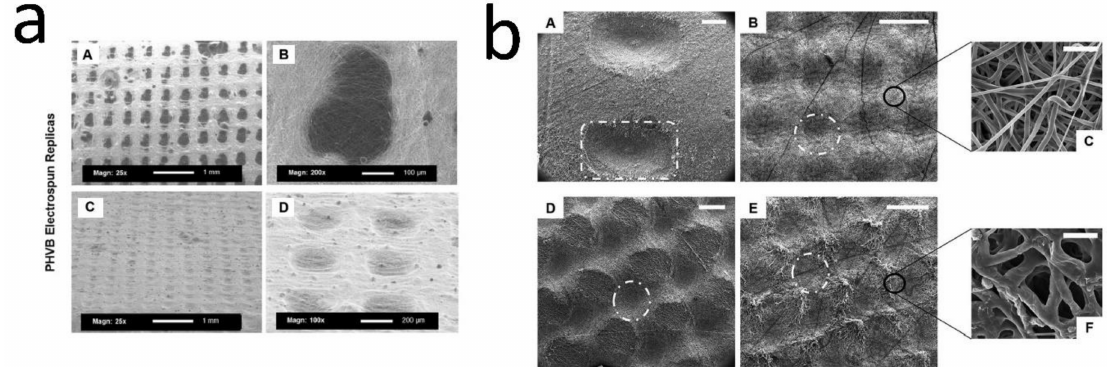
Figure 5. ( a ) Example of the electrospun membrane replicas for both square and rectangular patterns (images A – D ). Photo reused with permission [14] © 2018 Journal of Tissue Engineering, SAGE JOURNALS. ( b ) SEM images of electrospun membranes with three different patterns: ( A ) Pattern A, ( B ) Pattern B, and ( C ) Pattern C (scale bar = 500 µ m). ( D ) Air plasma treatment affected the topography of electrospun membranes, scaffolds made with pattern B. Magnifications of specimens with pattern B before ( E ) and after ( F ) air plasma treatment (scale bar = 10 µ m). Photo reused with permission [115] © 2021, American Chemical